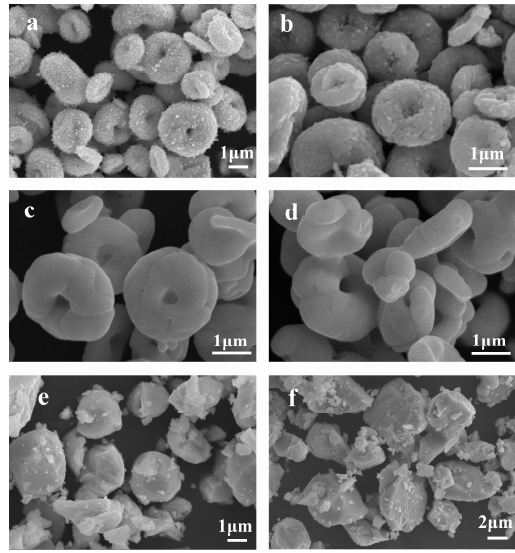
Figure 3. Typical SEM images of: ( a ) H0; ( b ) H400; ( c ) H500; ( d ) H600; ( e ) H700; and ( f ) H800.